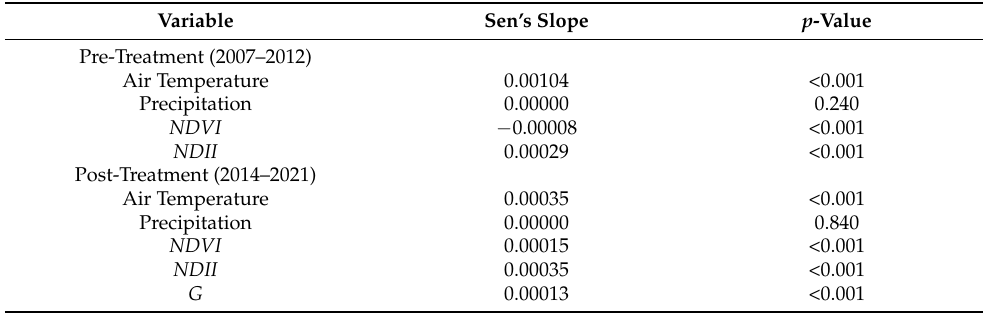
Table 6. Results from the trend analysis of pre- and post-treatment conditions for the variables